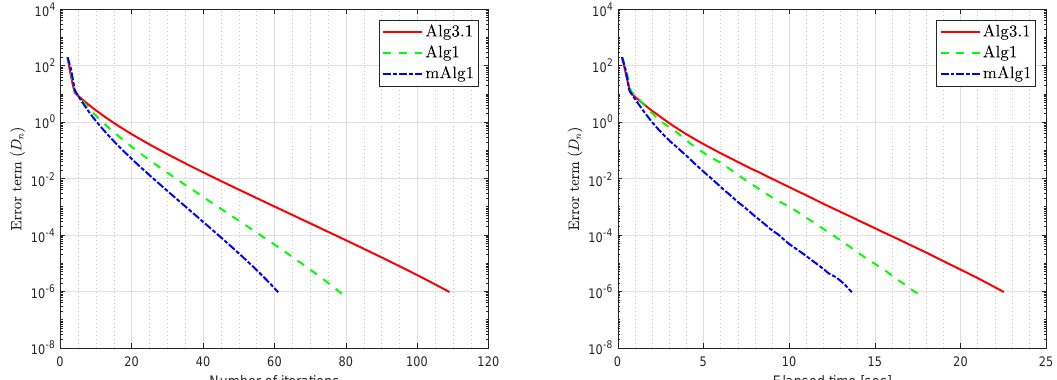
Figure 12. Example 4: Algorithm 1 (mAlg1) numerical comparison with Algorithm 3.1 (Alg3.1) in [39] and Algorithm 1 (Alg1) in [38] while m = 200.